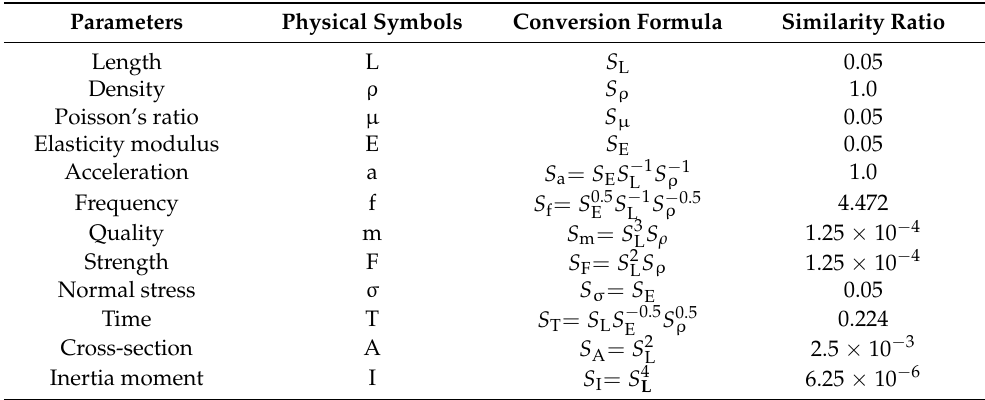
Figure 1. Victory Bridge after the Tangshan earthquake (unit: mm). Table 2. Similitude